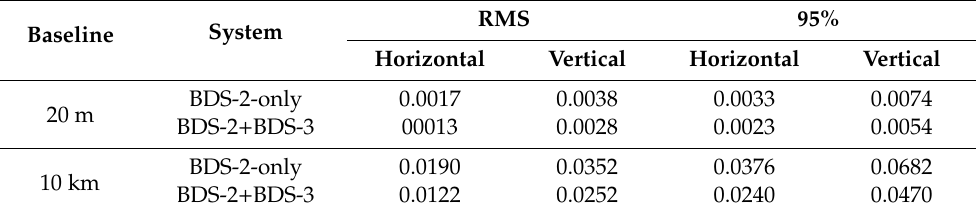
Table 6. RTK performance of BDS-2-only and BDS-2 + 3 for 20 m baseline and 10 km baseline (in